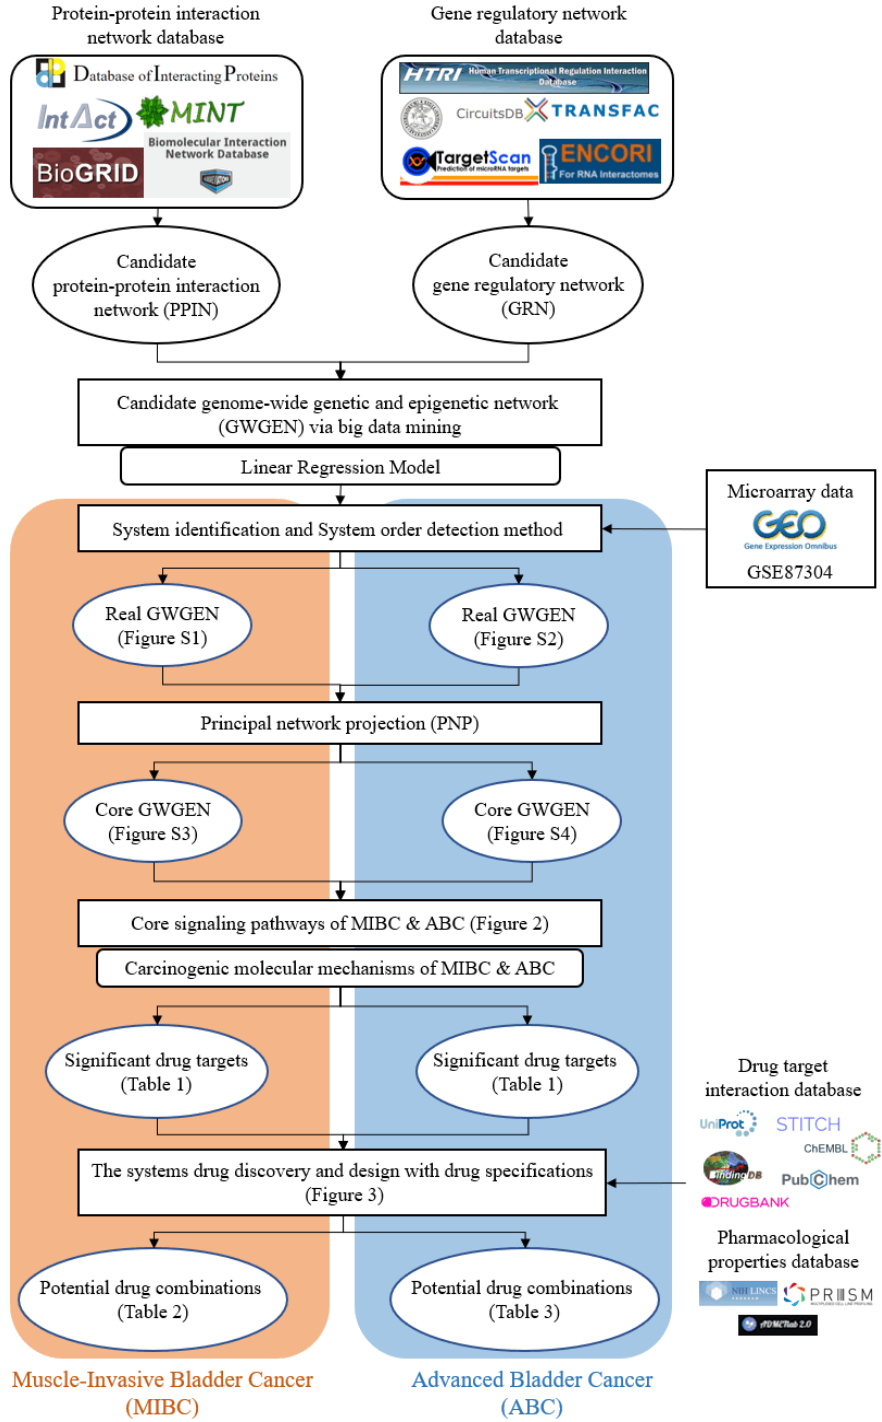
Figure 1. The flowchart of the systems biology method and systematic drug discovery design. The construction of candidate GWGEN, real GWGEN, core GWGEN and core signaling pathways for investigating carcinogenic mechanisms to identify the biomarkers as drug targets of MIBC and ABC, and systematic drug discovery and design of potential drug combinations as multiple-molecule drugs to target the corresponding multiple drug targets for the treatment of MIBC and ABC.